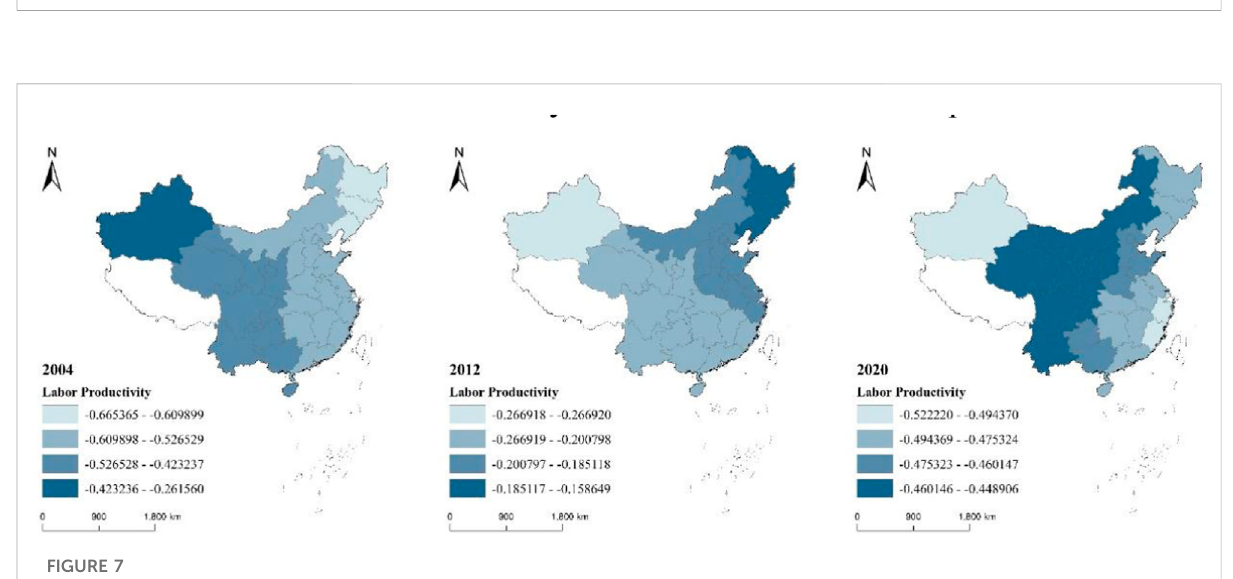
FIGURE 7 Regression coef fi cients for labor